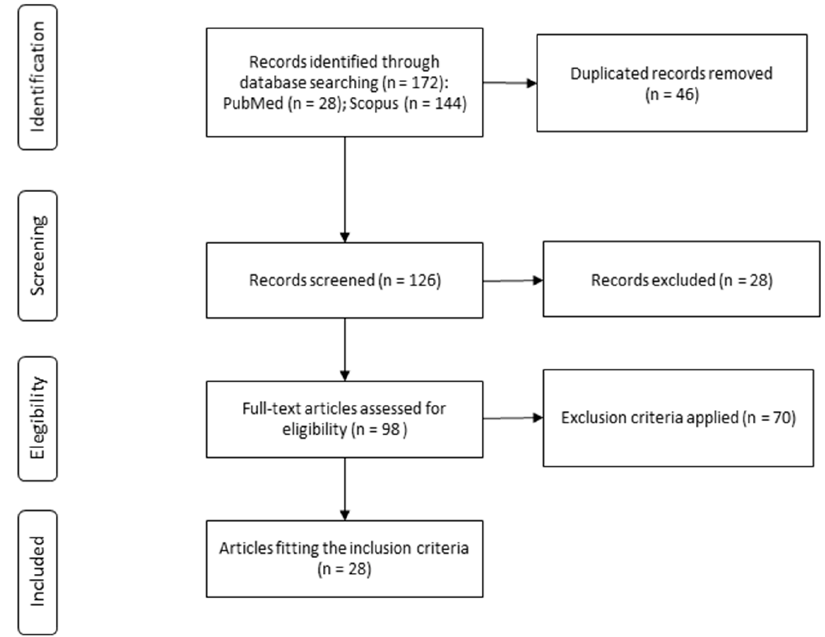
Figure 1. Study selection process for the systematic review.